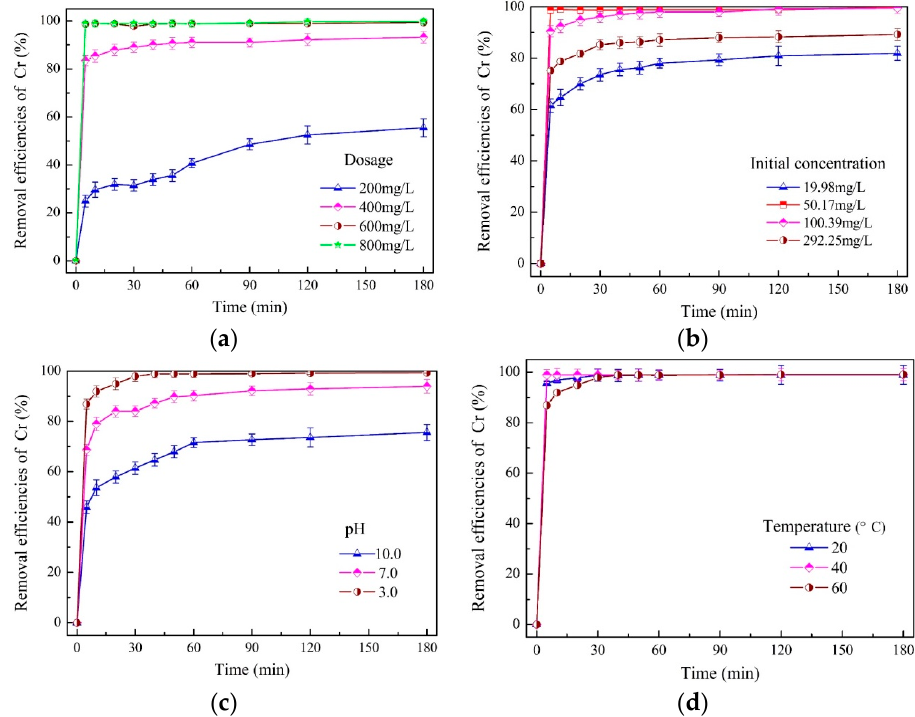
Figure 8. Results of batch experiments as per ( a ) dosage, ( b ) initial concentration, ( c ) pH value, and ( d ) temperature.